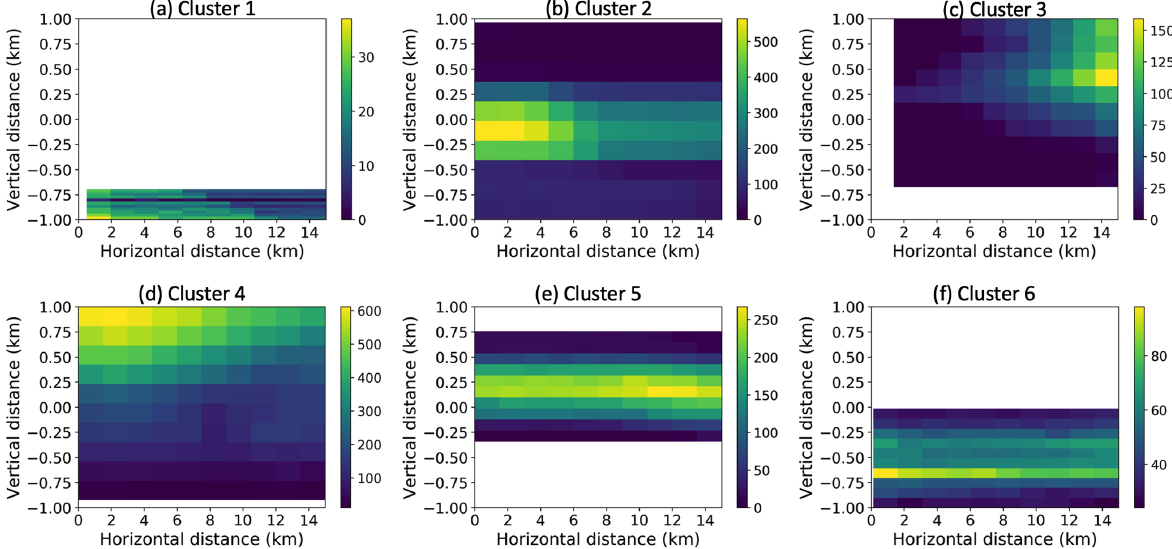
Figure 11. Two-dimensional histograms of occurrences of distances in the vertical and horizontal between in situ measurements and radar gates for Cluster 1–6 in (a) – (f) , respectively. Note that occurrences are counted for all pairs of in situ data points and radar gates. In calculations of retrieval errors, selected in situ data points and radar gates are only used once with equal